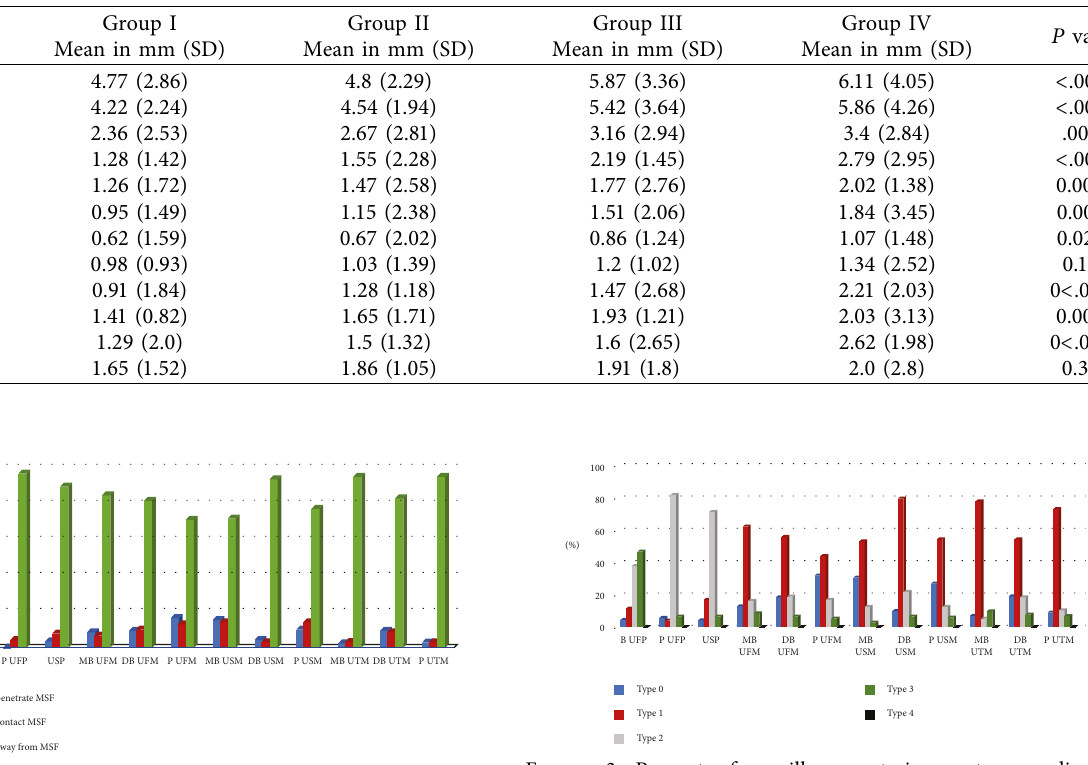
Table 2: The mean distance of different maxillary posterior roots from MSF stratified by age groups.